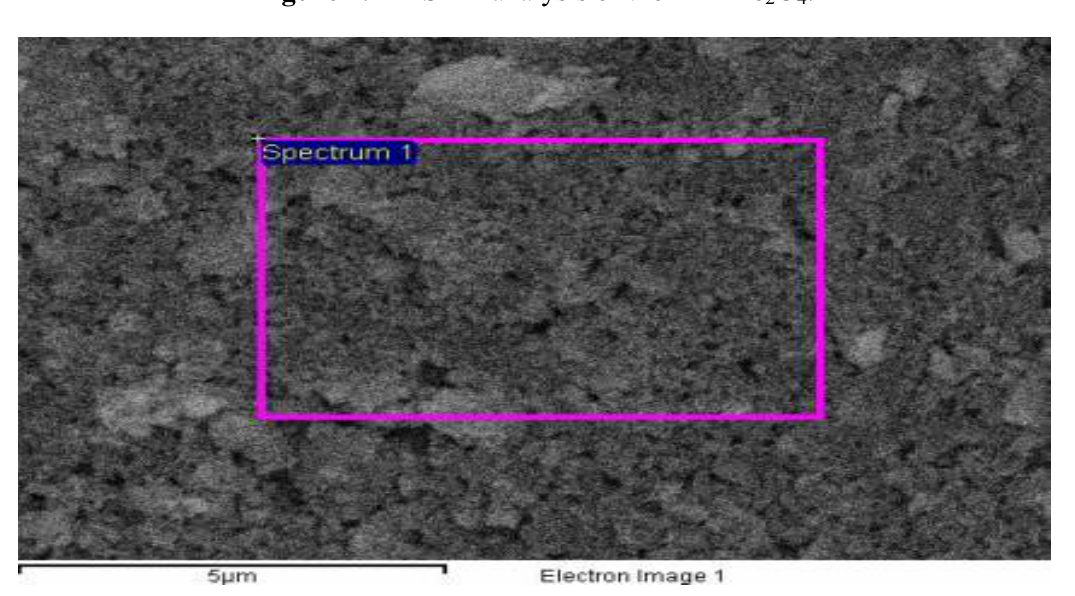
Figure 2. EDX spectrum of AlZnFe